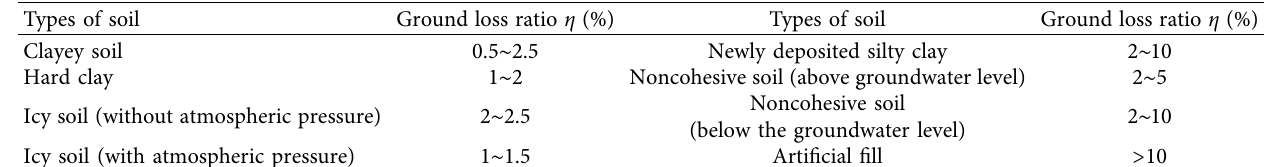
Table 4: Empirical values for ground loss ratios.